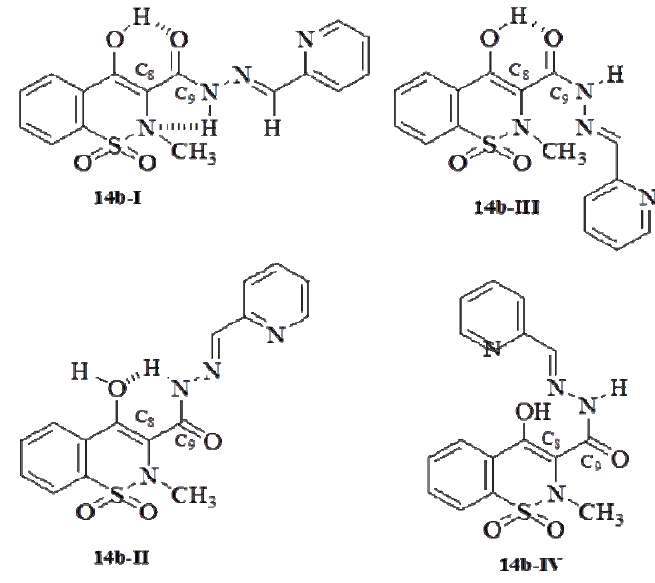
Figure 5. Possibles conformations of compound 14b (LASSBio-1617).